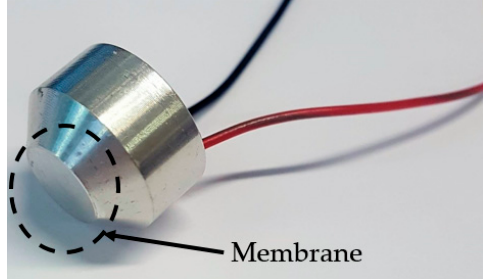
Figure 2. The flexural ultrasonic transducer (FUT) utilized in this study.